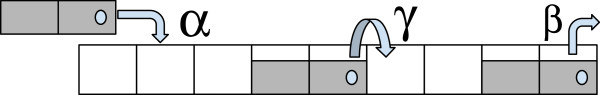
The codon-based model for mRNA translation. The codon-based lattice model for mRNA translation. The mRNA is represented by a one-dimensional lattice with each site being one codon on the mRNA. The ribosome attaches the leftmost end of the mRNA (initiation, the entry event) at some rate α, hops one codon towards its right (elongation, the hopping event) at some rate γ (possibly codon dependent) and exits from the rightmost point (termination, the exit event) at some rate β. Multiple ribosomes can be on the mRNA simultaneously.